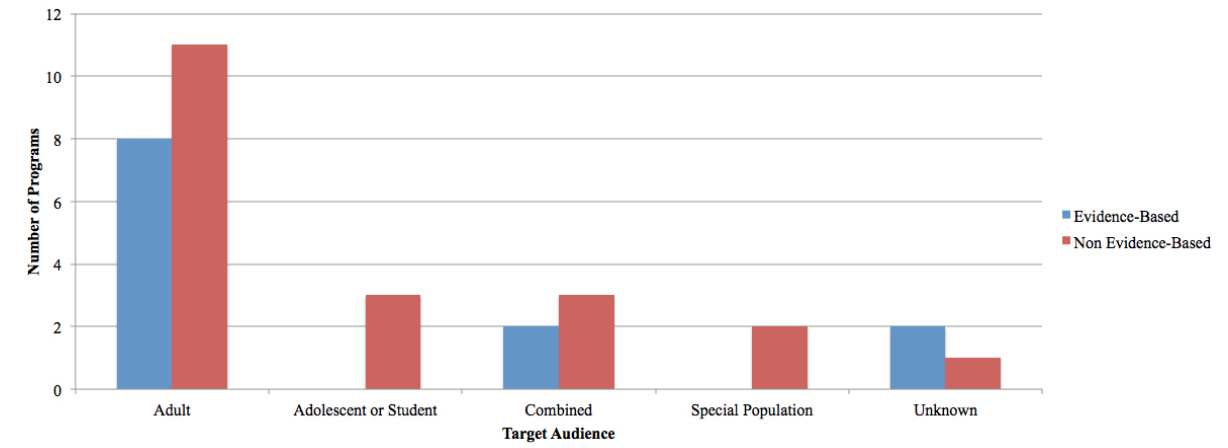
Figure 4. Target audience(s) of the